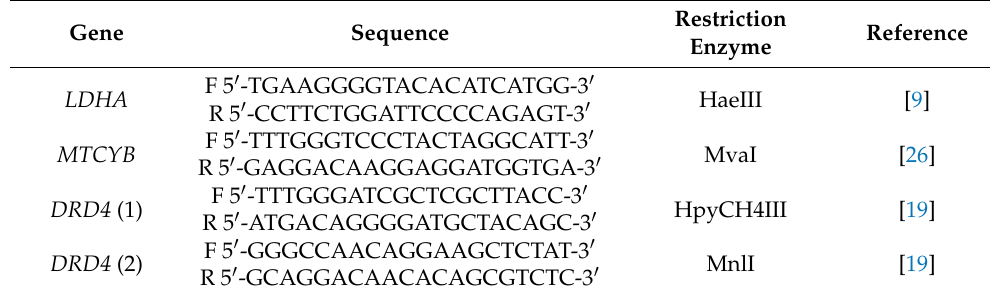
Table 1. Primers used for